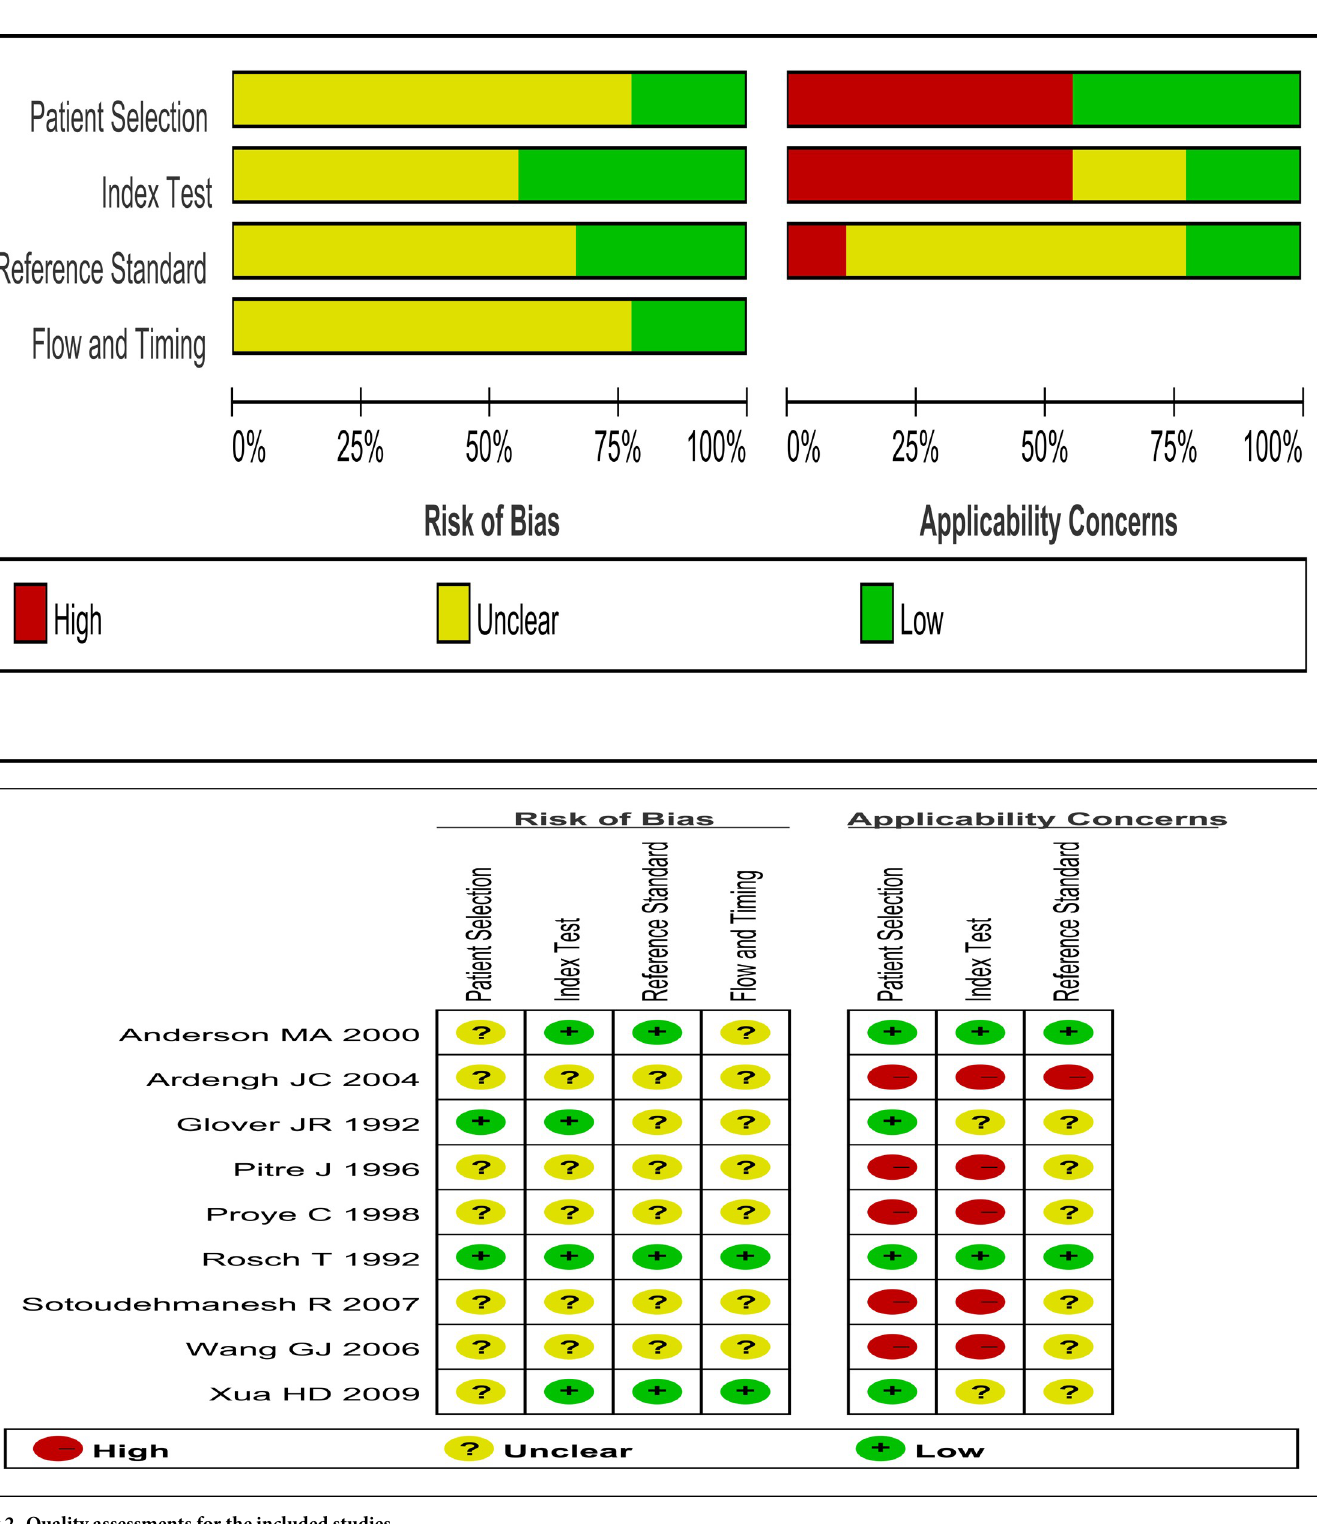
Fig 2. Quality assessments for the included